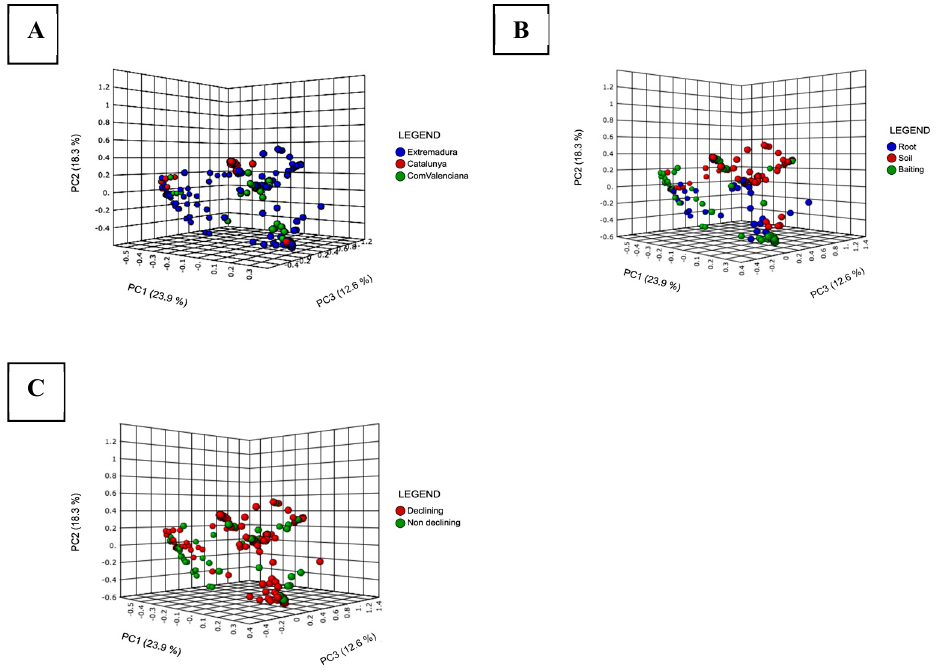
Figure 4. Principal Coordinate Analysis (PCoA) based on Bray Curtis dissimilarity metrics, showing the distance in the Phytophthora spp. composition according to the different factors studied. ( A) : Regions surveyed; Extremadura, Comunidad Valenciana (ComValenciana) and Cataluña (Catalunya). ( B) : Type of material used for the detection; roots, soils and baitings. ( C) : Symptomatology of the holm oaks sampled: declining and non-declining. Forests 2019, 10, x FOR PEER REVIEW